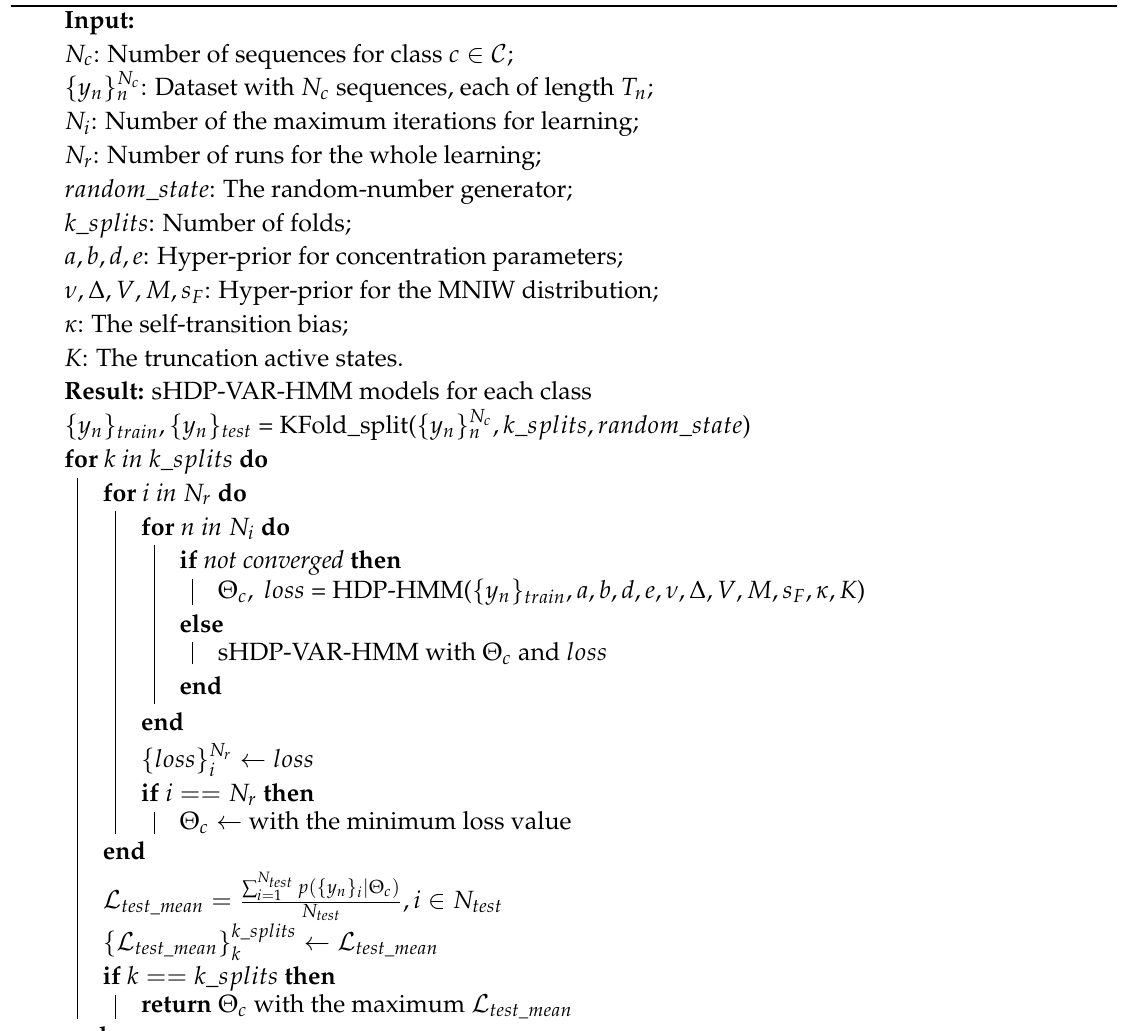
Algorithm 1: Training model for anomaly